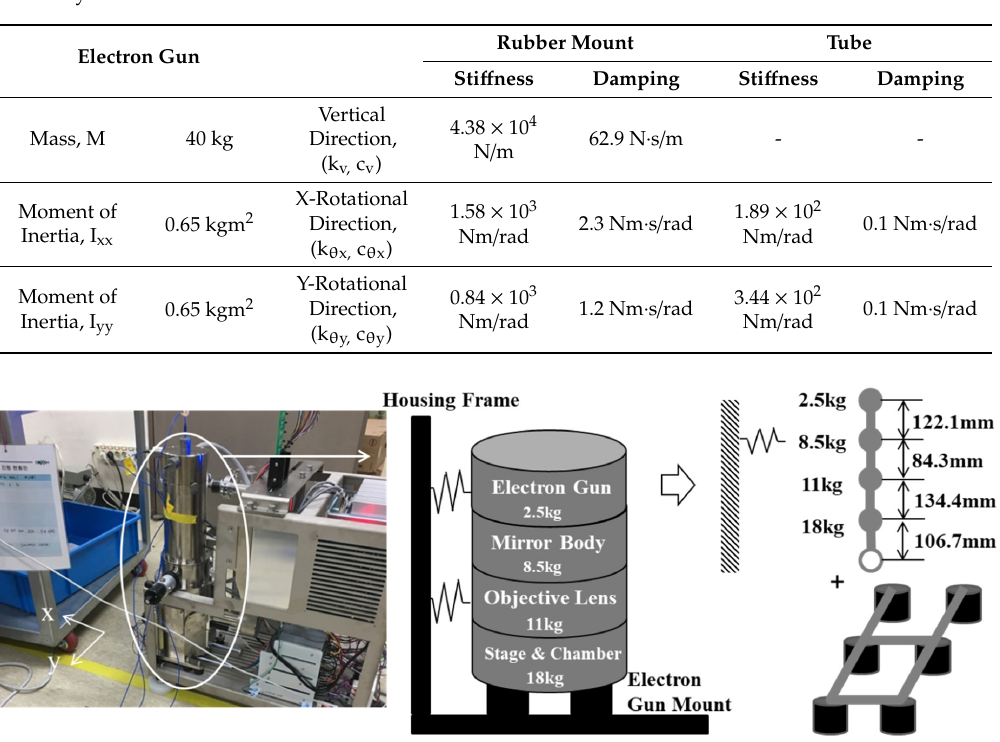
Figure 13. The difference between the calculated rotational natural frequencies and measured results was compensated by the equivalent stiffness from the tube connected to the electron gun. The vibration in the housing frame, i.e., the input to the gun, was measured. Table 2. Parameters used in the simplified mathematical model of the electron gun–rubber mount system.